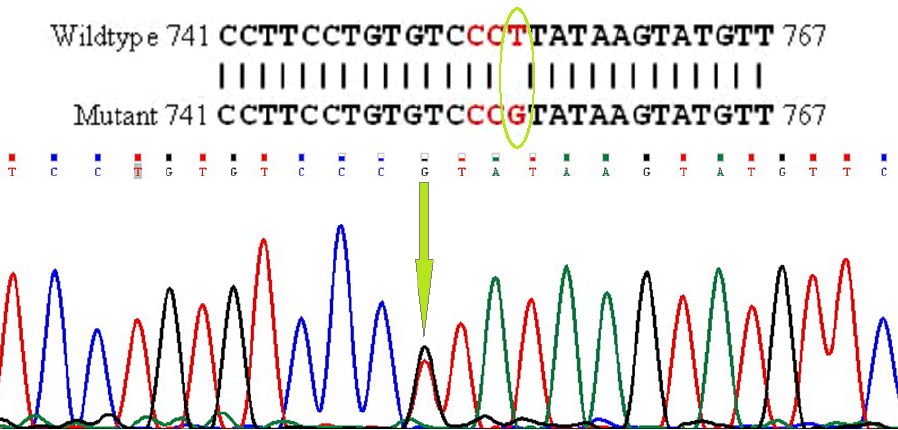
Figure 1. Partial sequence of BMP15 (exon II) and T to G transition in heterozygote goat.